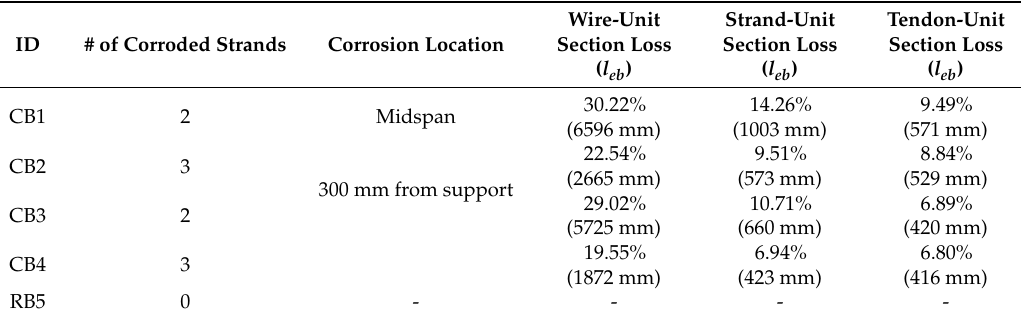
Table 1. Beam test